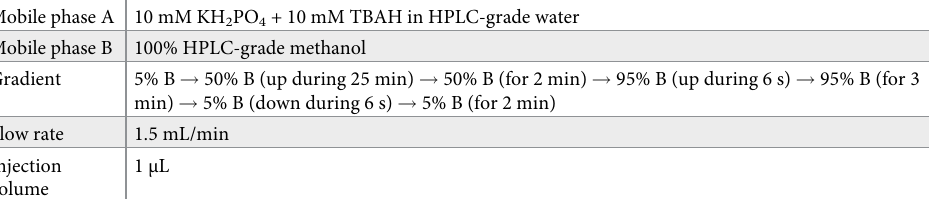
Table 2. HPLC method for G, C, I, and U nucleotides